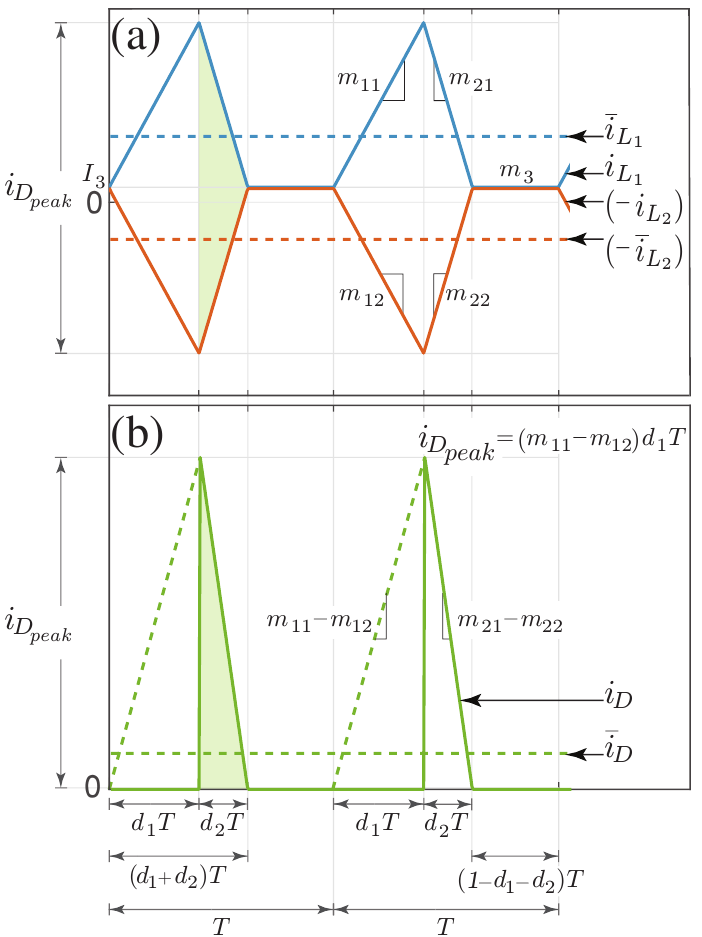
Figure 4. Relation between inductor and diode currents in steady state: ( a ) inductor currents, ( b ) diode